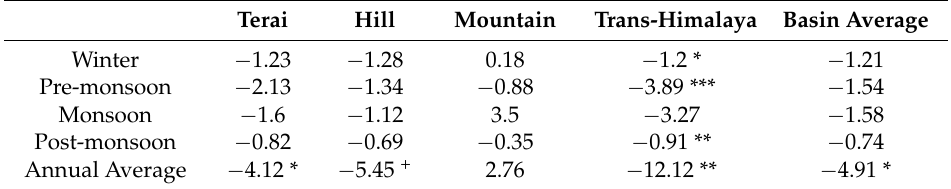
Table 1. Precipitation trend (mm/year) in KRB at different seasons and agro-ecological zones. Terai Hill Mountain Trans-Himalaya Basin Average Winter ´ 1.23 ´ 1.28 0.18 ´ 1.2 * ´ 1.21 Pre-monsoon ´ 2.13 ´ 1.34 ´ 0.88 ´ 3.89 *** ´ 1.54 Monsoon ´ 1.6 ´ 1.12 3.5 ´ 3.27 ´ 1.58 Post-monsoon ´ 0.82 ´ 0.69 ´ 0.91 ** ´ 0.74 Annual Average ´ 4.12